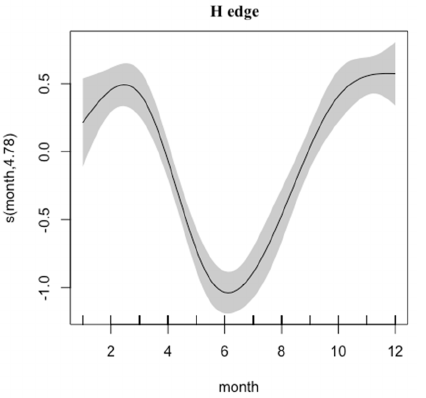
Figure 3. Plot of the proportion of hyaline (H) edges for the Age 1 class by month.